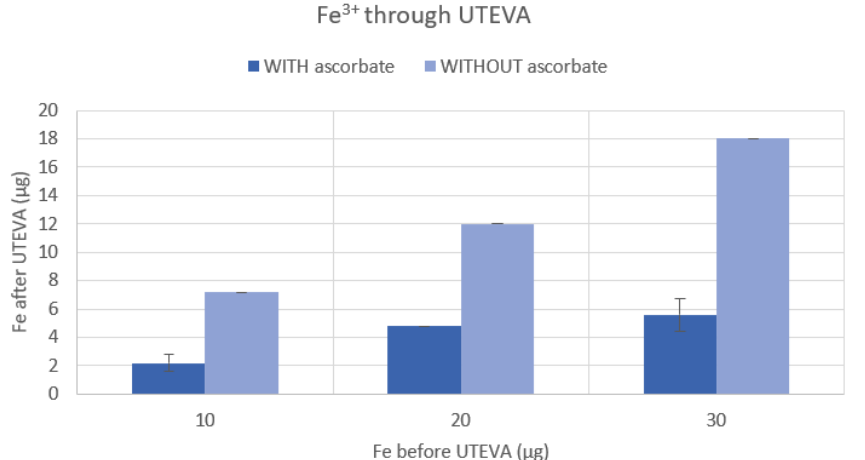
Figure 4. Comparison between the iron present in the eluate when the UTEVA resin was washed with sodium ascorbate added HCl ( n = 3) and HCl without sodium ascorbate ( n = 3). The Student’s t -test showed p -values < 0.001, which were considered significant. The iron concentrations were analyzed using a colorimetric test